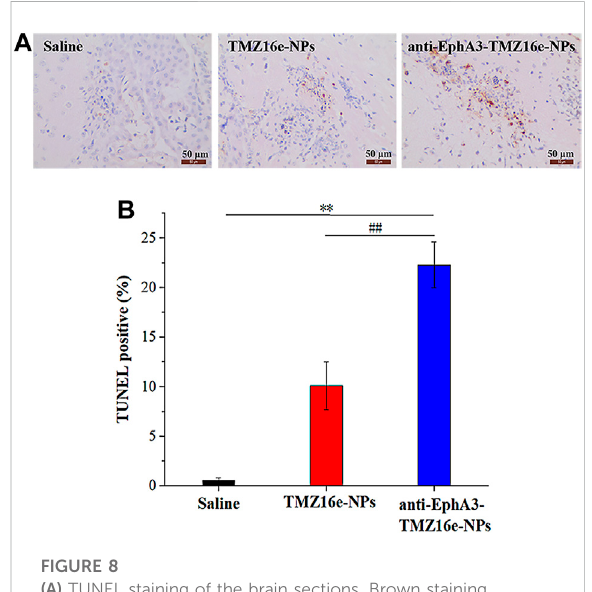
FIGURE 8 (A) TUNEL staining of the brain sections. Brown staining